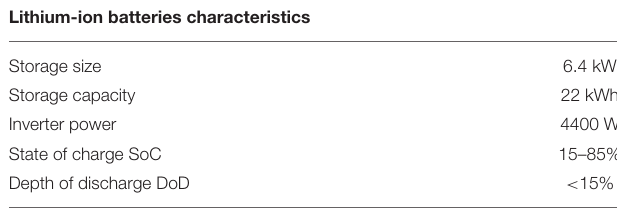
TABLE 1 | Technology and operation features of EES.